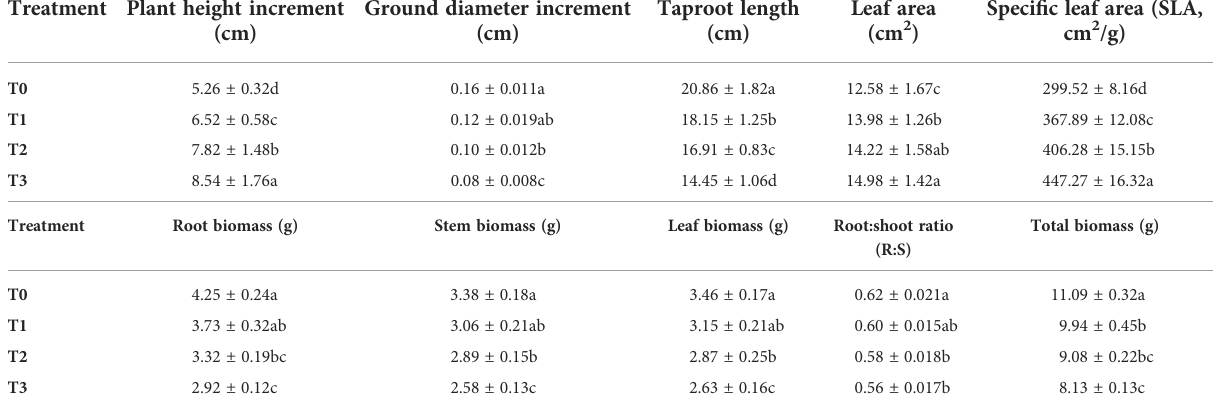
TABLE 1 Effects of various light intensities on plant height increment (cm), ground diameter increment (cm), taproot length (cm), leaf area (cm 2 ), speci fi c leaf area (SLA, cm 2 /g), roots, stems and leaf biomass (g), root:shoot ratio (R:S) and total biomass (g) after 60 days of treatment. Treatment Plant height increment